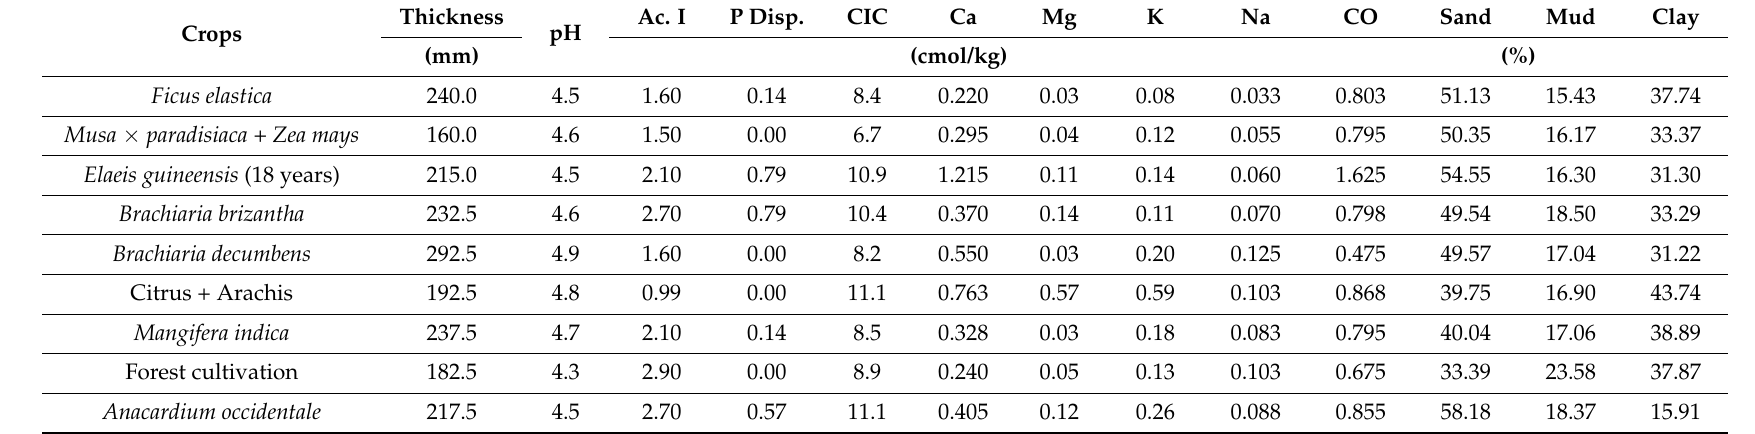
Table 3. Thickness values, pH, exchangeable acidity, available phosphate cation exchange capacity, calcium, magnesium, potassium, sodium, organic carbon, sand, lime, and clay of horizon